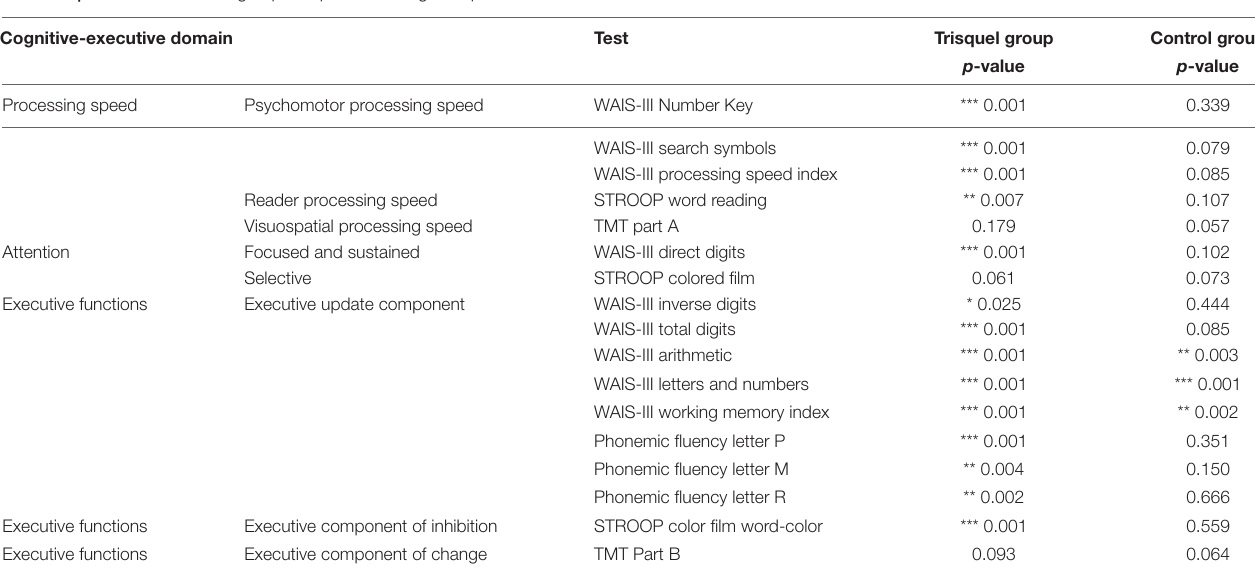
TABLE 4 | Process-based intragroup comparison of cognitive